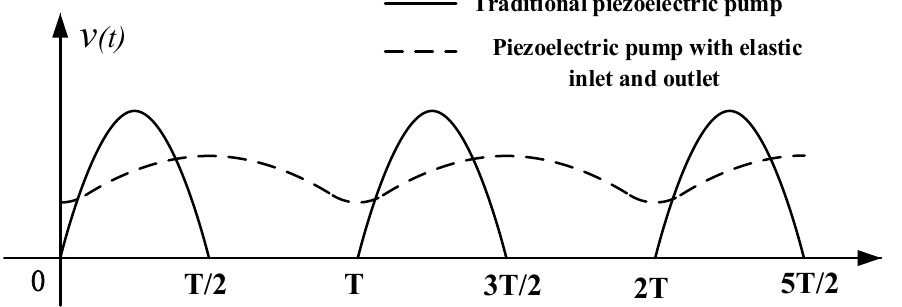
Figure 3. Velocity curves of liquid in the pipelines of the traditional piezoelectric pump and the piezoelectric pump with elastic inlet and outlet.